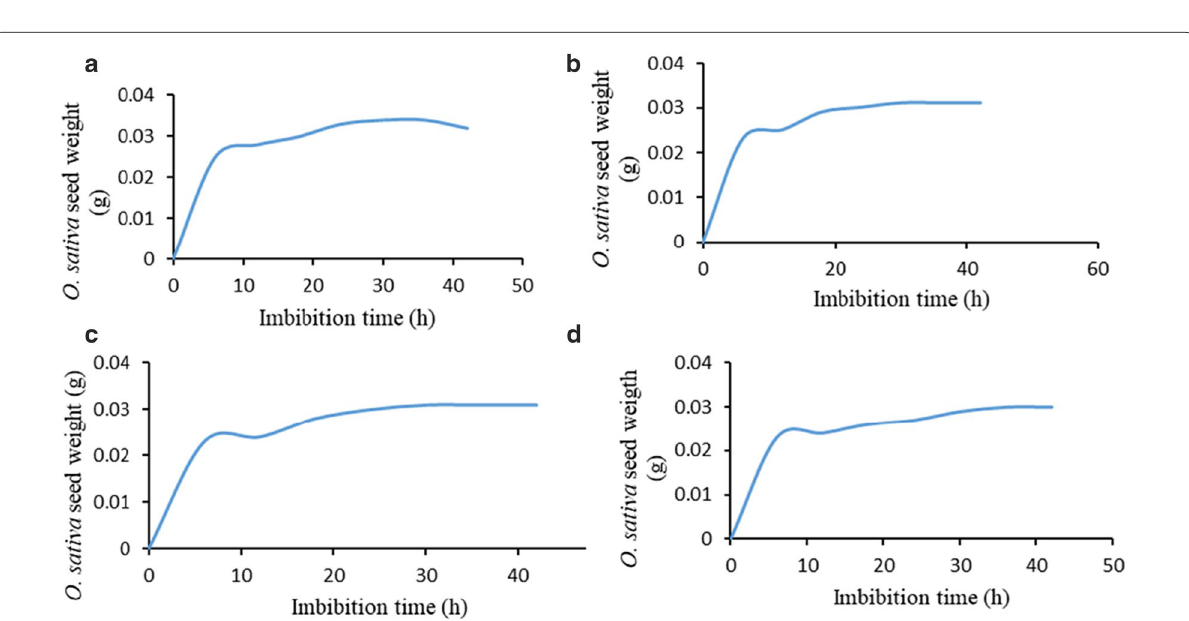
Fig. 3 Imbibition rate of rice germinants after exposure to